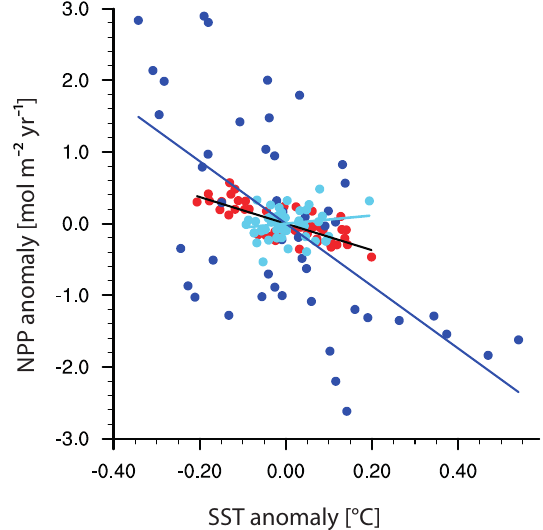
Fig. 3. Relationship between anomalies of annual mean depth- integrated NPP [molC m − 2 yr − 1 ] and anomalies of annual mean SST [ ◦ C] for three regions. Each dot represents one year, with the low latitude average (30 ◦ S–30 ◦ N) shown in dark blue, high lati- tude average shown in light blue and the global average shown in red. Anomalies are defined here as the deviation of annual mean SST (NPP) from the 1960–2006 mean of SST (NPP) in the respec- tive regions.